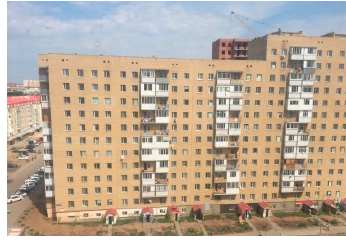
Figure 2. Economy class building.